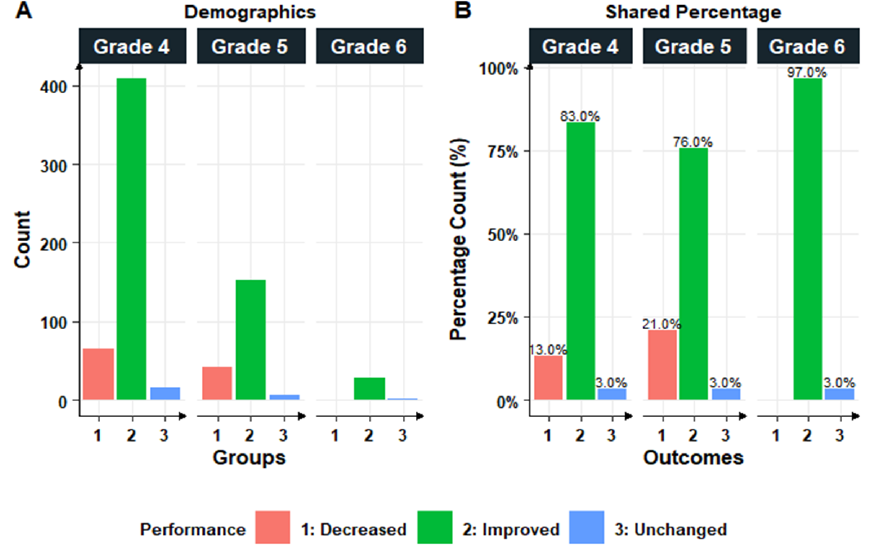
Figure 6. Overview of students’ performance variation over time.